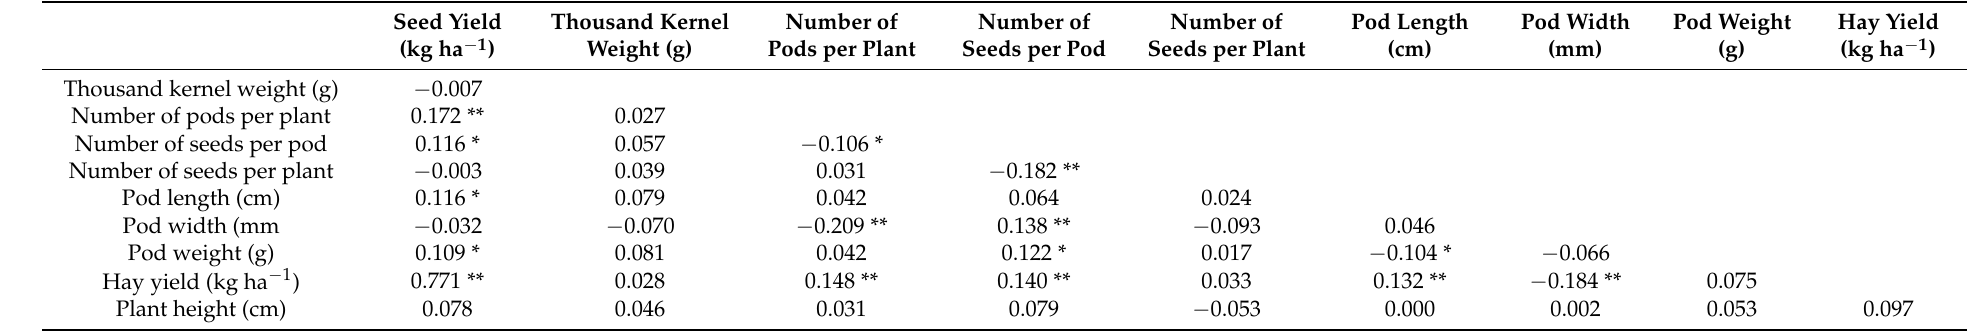
Table 4. Correlations between all the traits measured: seed yield (kg ha − 1 ), thousand kernel weight (g), number of pods per plant, number of seeds per pod, number of seeds per plant, pod length (cm), pod width (mm), (mean) pod weight (g), hay weight (kg ha − 1 ), plant height